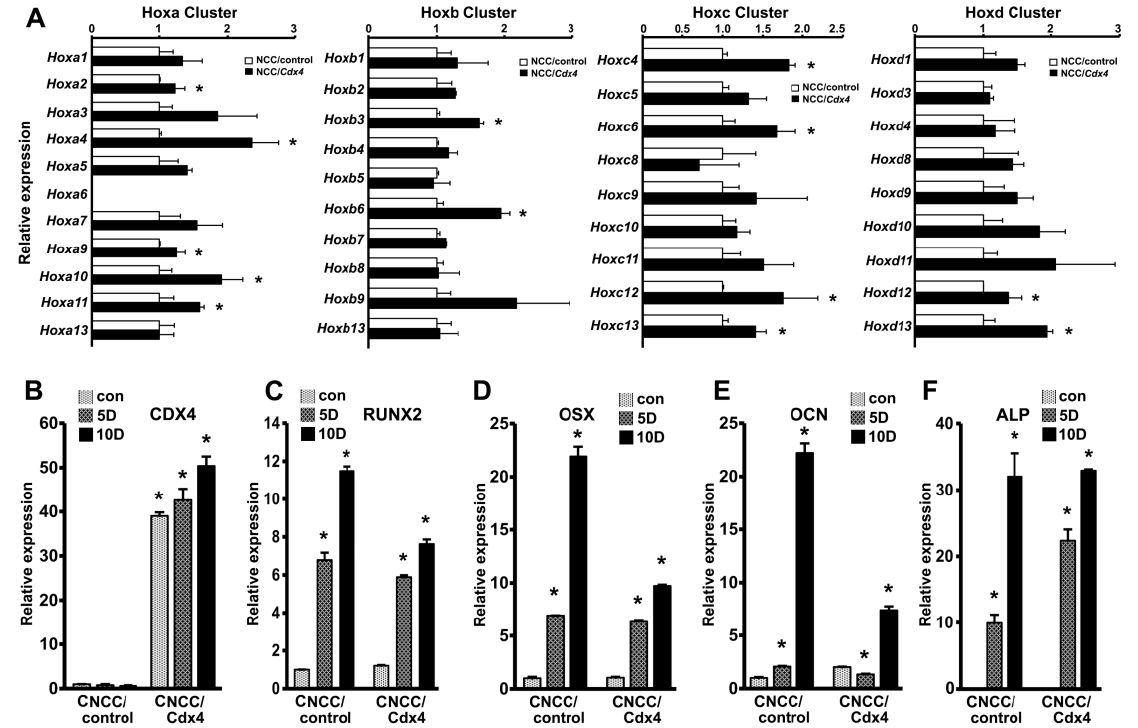
Figure 4. Cdx4-mediated HOX gene activation suppresses CNCC mineralization potential. ( A ) q- PCR comparison of HOX gene expression in mouse CNCC control cells (CNCC/control) and CNCC stably expressing CDX4 (CNCC/CDX4). Expression data are from biological replicates, n = 7. ( B ) Comparison of CDX4 transcript levels in CNCC/control and CNCC/Cdx4 cells during the course of in vitro mineralization induction. CDX4 transcript levels were consistently high in the CNCC/Cdx4 group throughout the experiment. Expression levels at each time point were compared to CNCC/control uninduced cells. ( C – F ) Comparison of mineralization-associated gene expression, including ( C ) RUNX2, ( D ) OSX, ( E ) OCN, and ( F ) ALP in CNCC/control and CNCC/Cdx4 cells after 5 or 10 days of in vitro mineralization induction. Expression at the 5-day and 10-day time point were separately compared to the corresponding control group and statistical significance determined, n = 7. Non-induced cells (con) from each group were used as controls. Differences were considered as statistically significant (*) at P < 0.05.